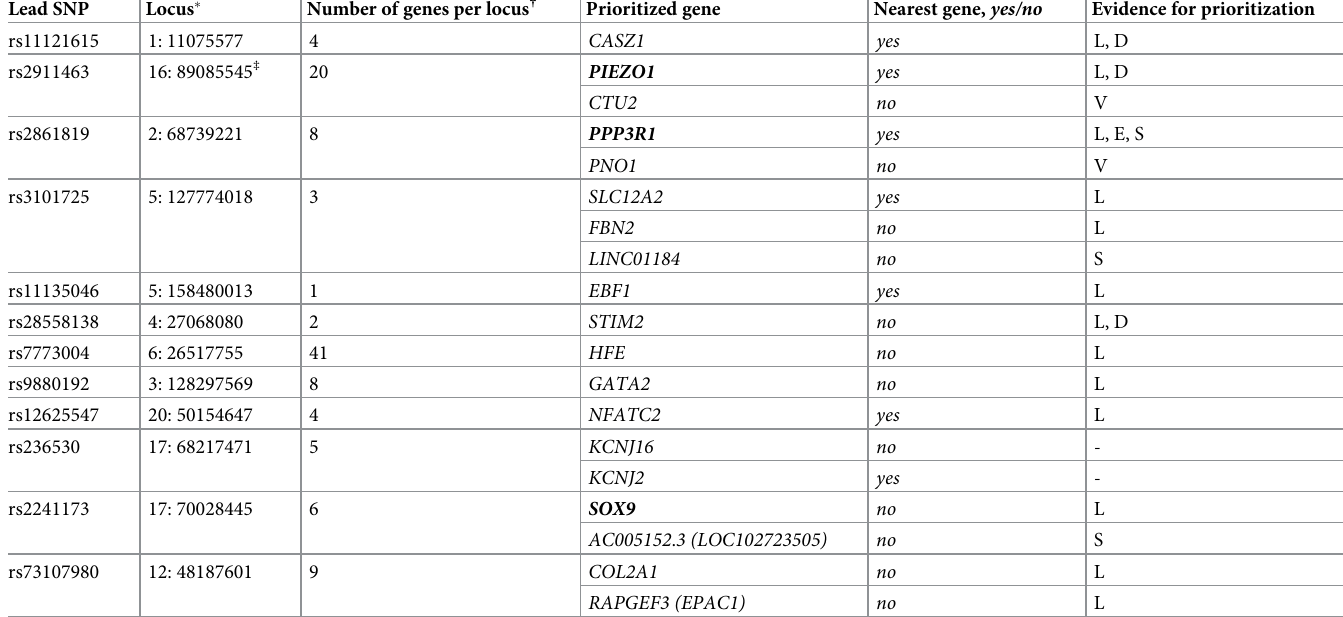
Table 2. Summary of gene prioritization.